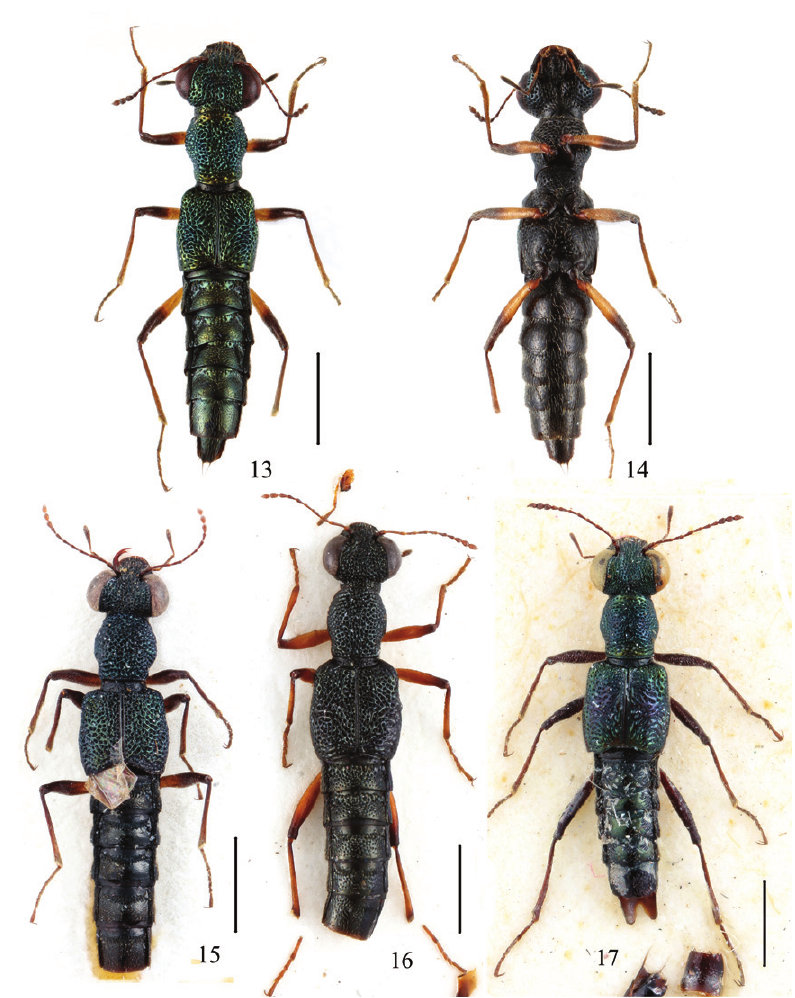
Figures 13–17. Adult habitus of Dianous. 13, 14 D. viridicupreus 15 D. yao 16 D. limitaneus 17 D. viriditinctus . Scales = 1 mm.